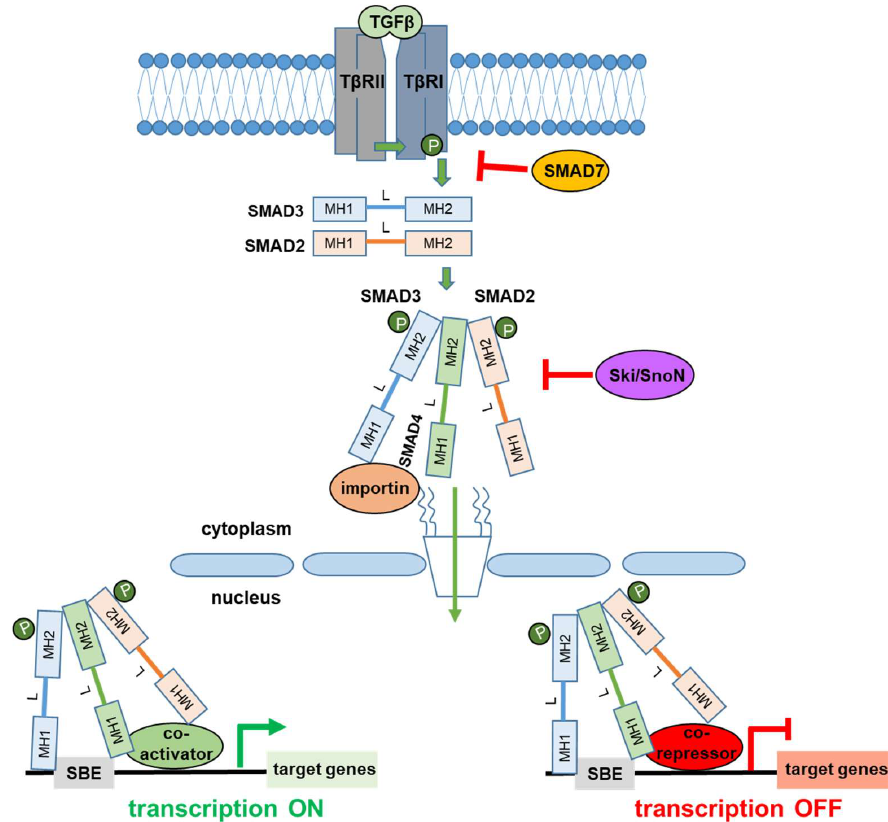
Figure 1. Basics of transforming growth factor β (TGF β ) signaling. Binding of TGF β ligands to their receptors initiates the signal, through the phosphorylation of T β RI by T β RII. Then, T β RI transmits